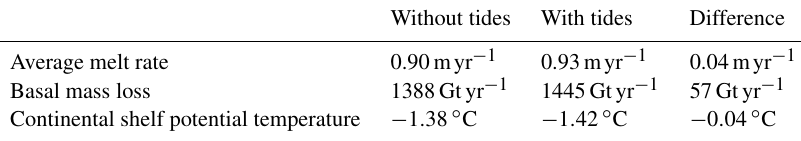
Table 1. Tide-induced difference in area-averaged melt rate, basal mass loss and continental shelf sea temperatures for all Antarctic ice shelves (averaging Figs. 2c and 4). Continental shelf temperatures have been calculated including the sub-ice shelf cavities and using a depth at the shelf break of 1000m.